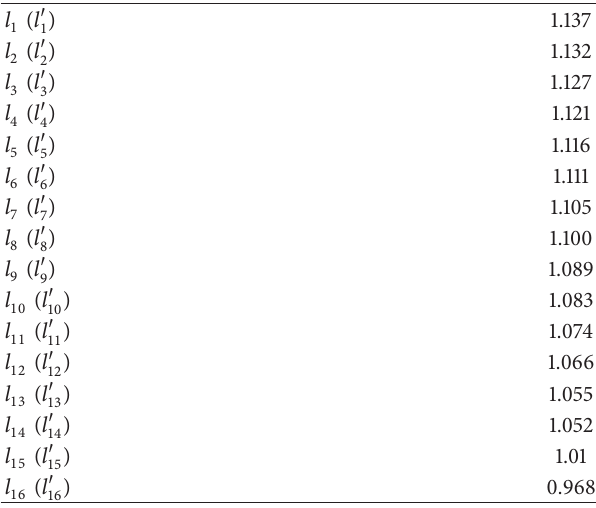
Table4:SlotlengthofasynthesizedlowSLLSIWslotantenna(unit: mm).